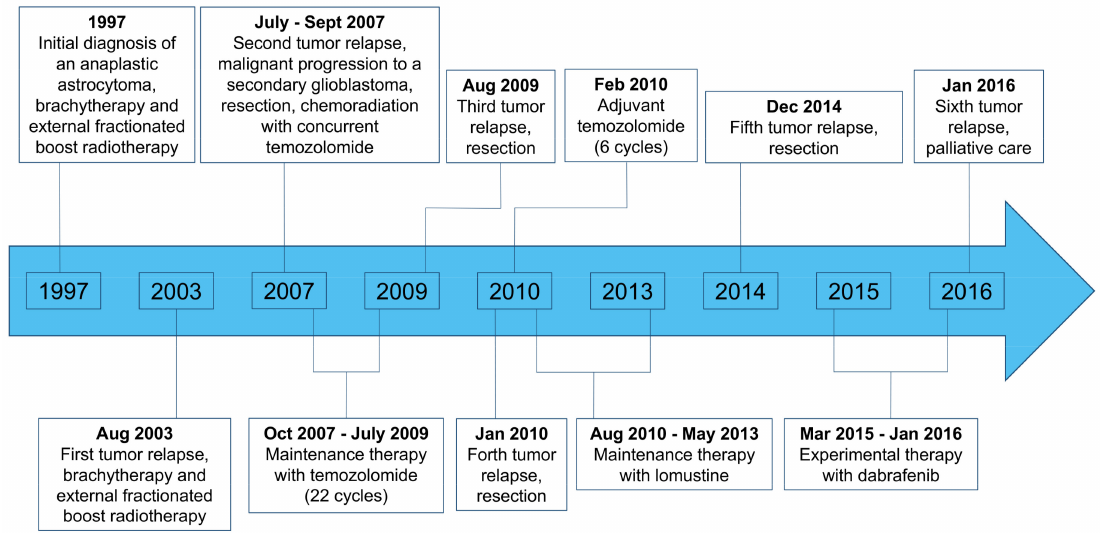
Figure 1. Overview of the patient’s course of disease and treatment